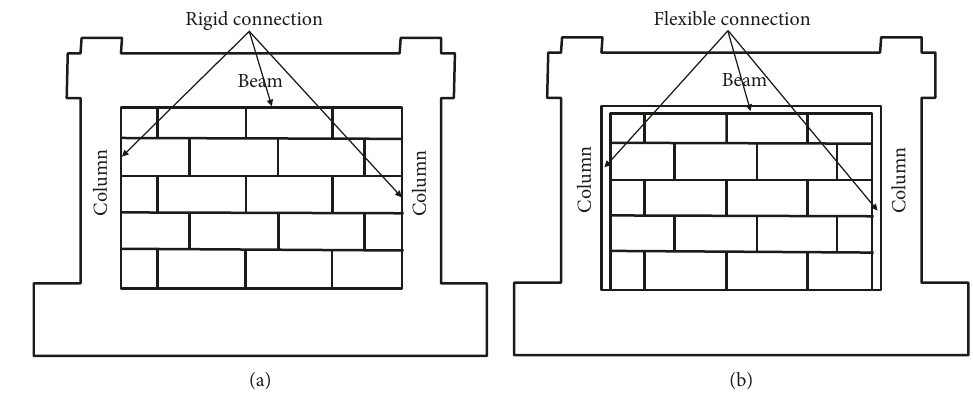
Figure 1: Connection types between infill wall and surrounding frame.